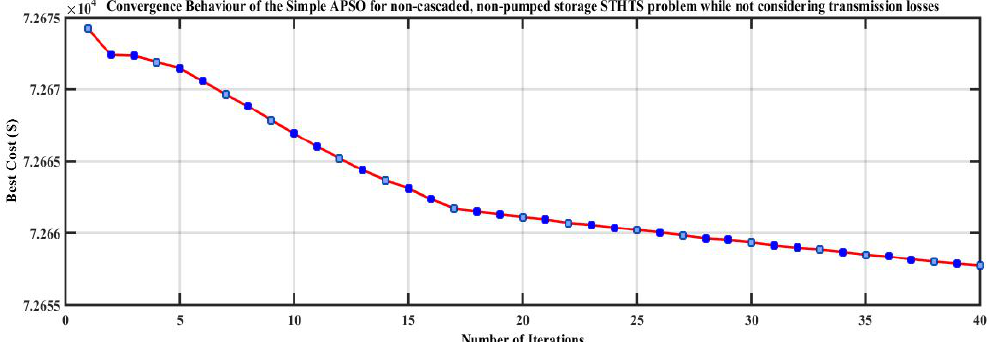
Figure 11. Convergence characteristics of the simple APSO algorithm on the non-cascaded non-pumped STHTS problem without transmission loss.